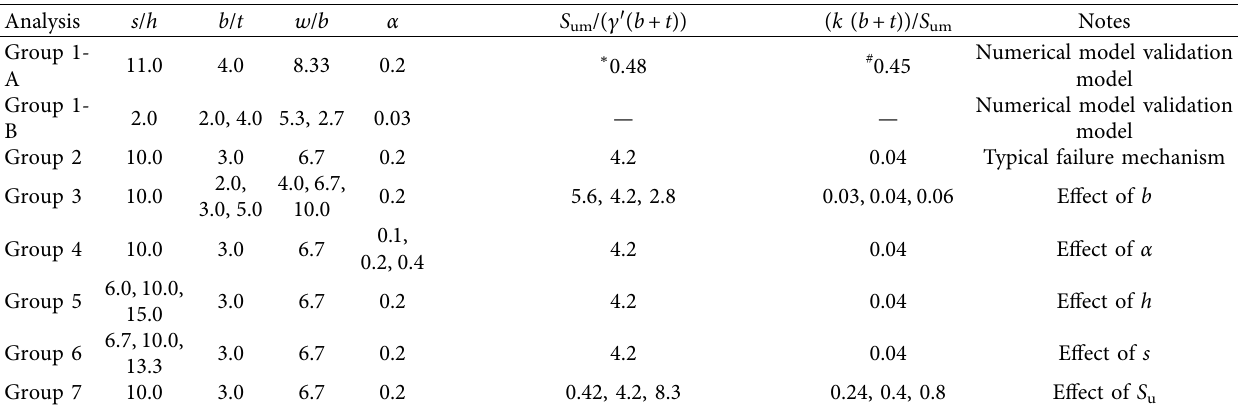
Figure 3: Mesh of RITSS code. (a) The initial mesh of LDFE/RITSS. (b) Dynamic mesh demonstration. (c) Established contact mesh. Table 1: Summary of LDFE